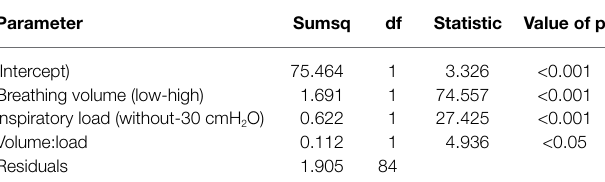
TABLE 4 | Type III ANOVA results for the thickness fraction.